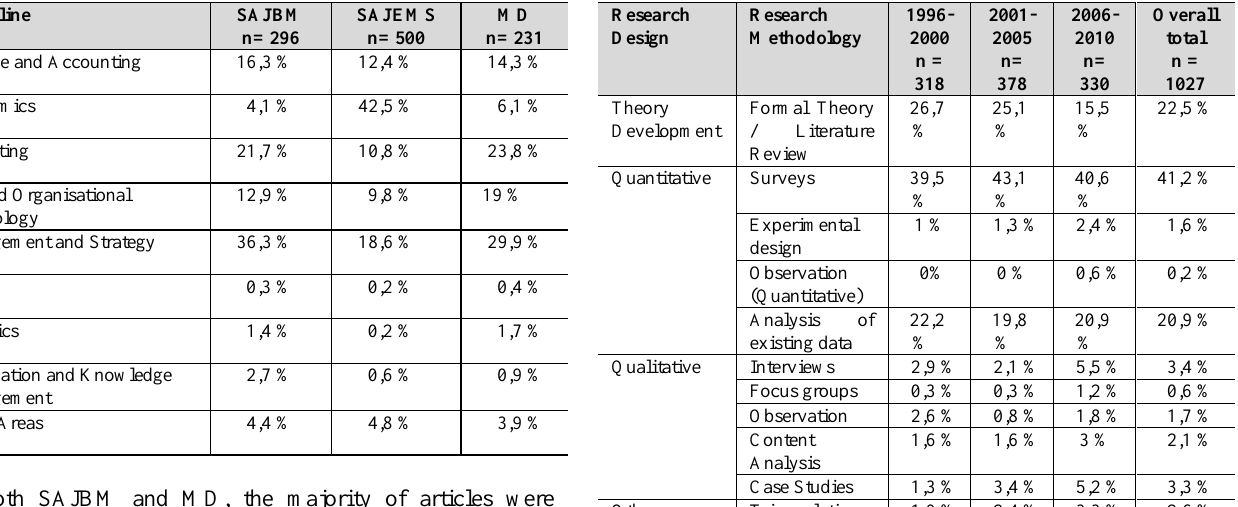
Table 6: Research areas of articles published in all three journals over all fifteen years